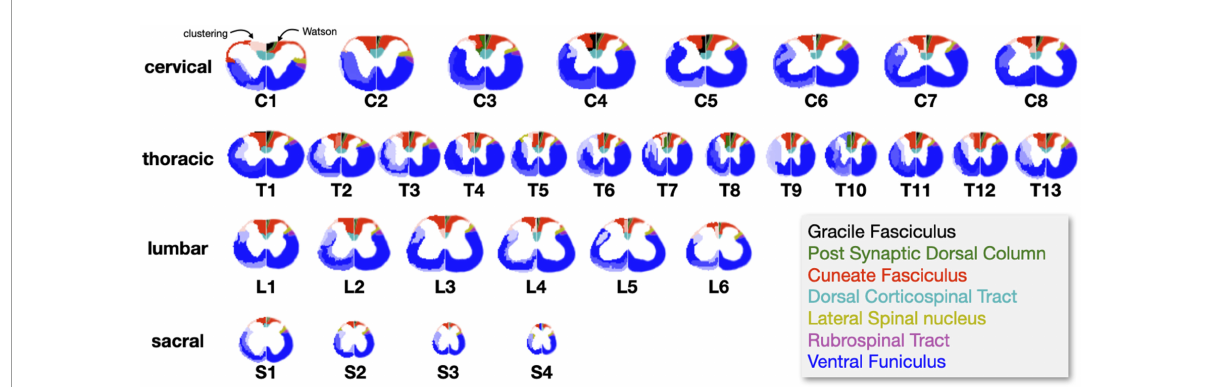
FIGURE4 Results of the slice-wise clustering for each spinal level (set to 8 clusters). Clustering results are shown on the left side of each spinal cord, and the Watson atlas is shown on the right side. Colors were chosen to topologically match between the two sides for easier assessment. Wherever the clustering resulted in parcellated clusters (where the Watson atlas would only show one funiculi), the intensity across parcellated clusters was varied (e.g., light blue, dark blue). The spatial scaling is kept the same.